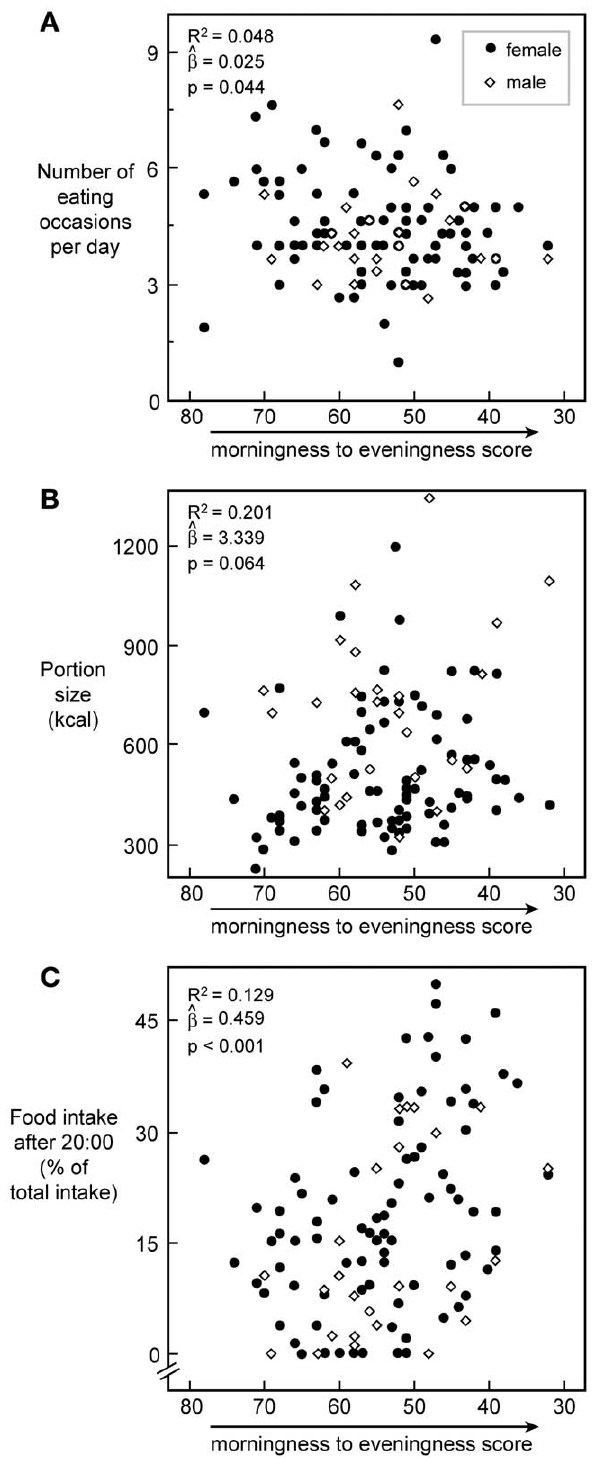
Figure 2. Pattern and timing of food intake vs. chronotype score. Plot of chronotype scores versus the number of eating occasions (A), the portion size (B), and the amount of caloric intake after 20:00 (C) with a trend line, respectively. N=113 for all. R 2 , slope, and p -value for the prediction of chronotype score on food intake variables in each plot are calculated from gender-corrected models. Closed circles represent women, open diamonds represent men.